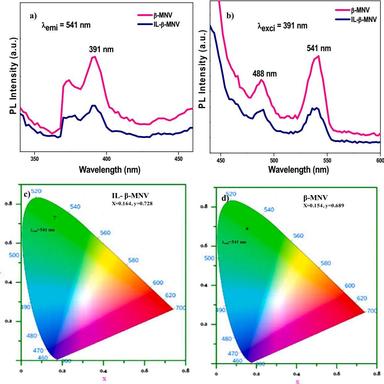
a) Expectation spectra; b) emission spectra; c) and d) CIE diagrams of IL-β-MNV and β-MNV, respectively.